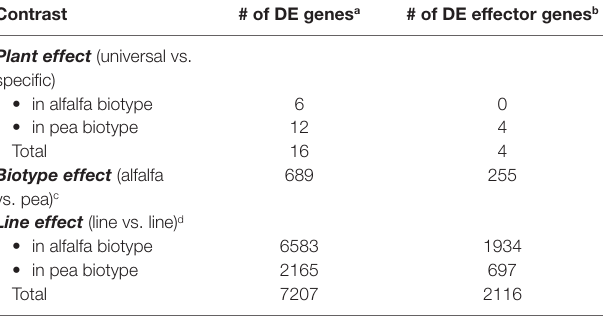
TABLE 1 | Differentially expressed genes in the head samples of the alfalfa and pea biotypes reared on the universal and specific host plants. Contrast # of DE genes a # of DE effector genes b Plant effect (universal vs.